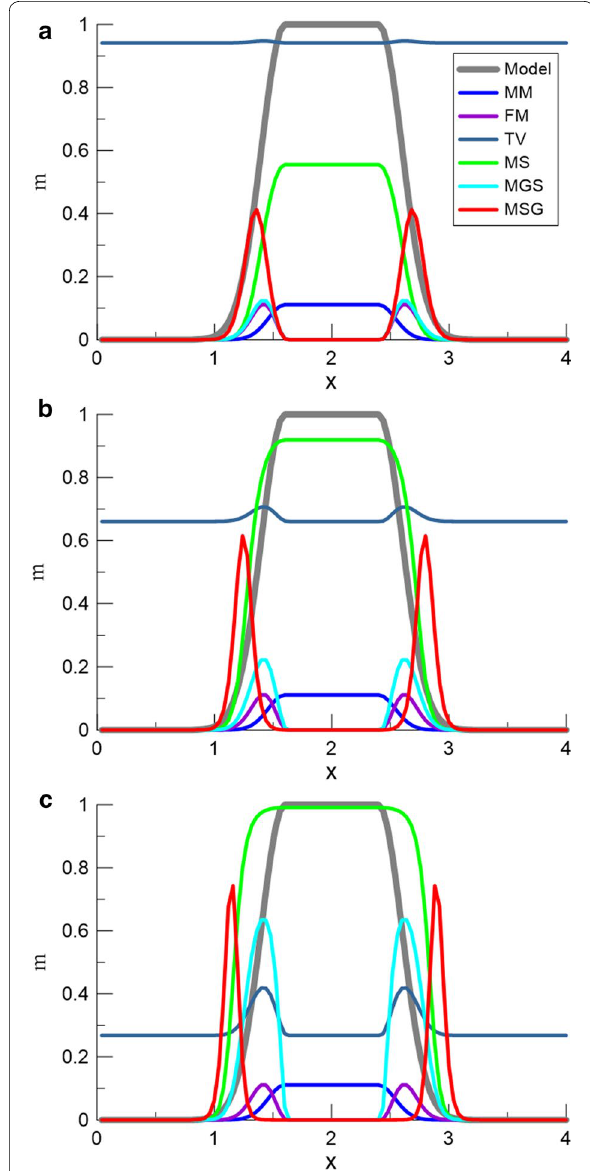
Fig. 1 Comparison of mathematical model distributions of different stabilizing functionals with square of focusing parameters β 2 of a 1, b 0.1, and c